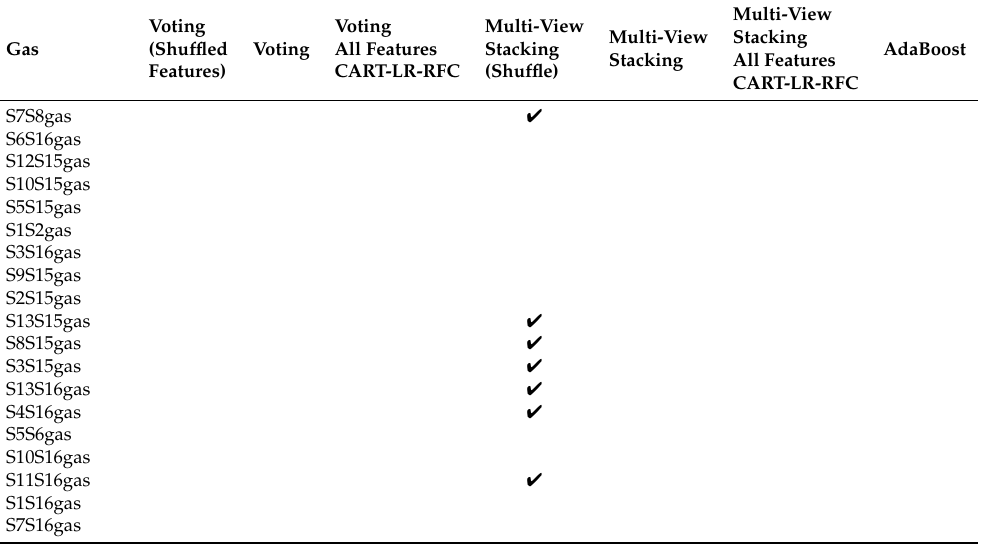
Table 9. Best fusion method for each Gas data set. A tick ( (cid:52) ) marks the best configuration when it is statistical-significantly better than